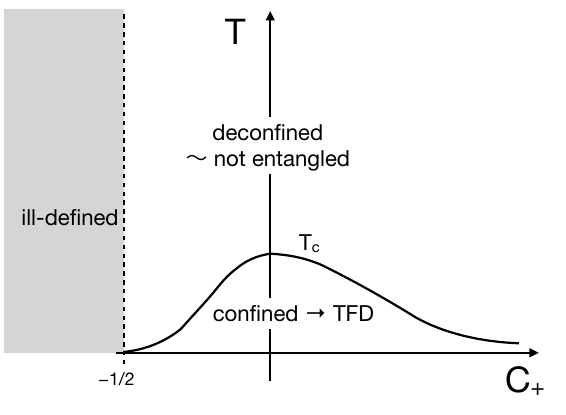
Figure 10 . The sketch of the phase diagram of the gauged Gaussian matrix model, with (1 + 2 C + )(1 − 2 C − ) = 1